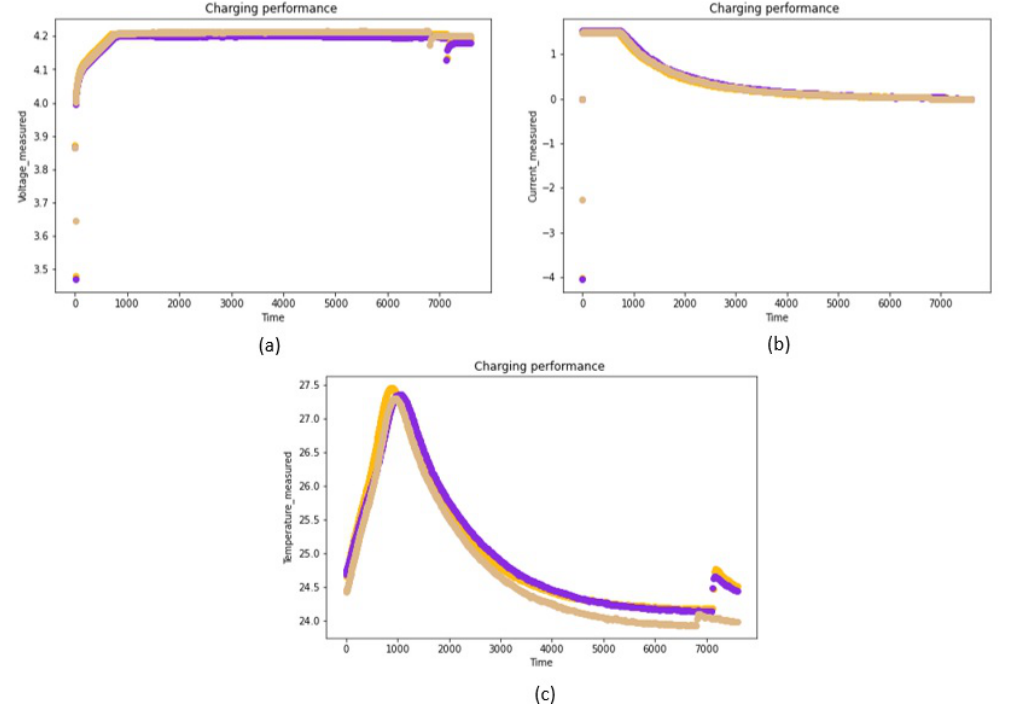
Figure 6. The process of charging the battery. ( a ): battery a charging curve performance; ( b ): battery b current curve performance; ( c ): battery c temperature curve